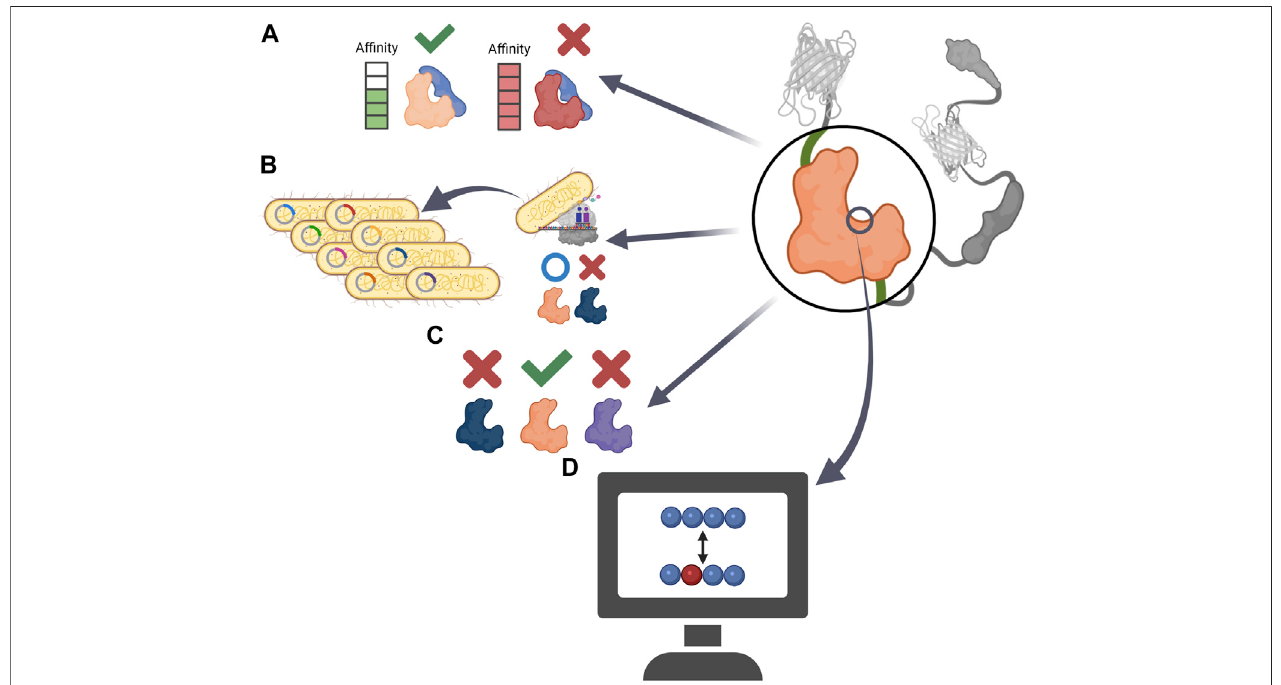
FIGURE3| Schematicprecedentsofliganddomainoptimization (A) ConstructingaGEBthatcanreversiblyrespondtoexternalstimulibyusingliganddomainwith adequate af fi nity to sensor domain. (B) By replacing the ligand domain that Escherichia coli could not express, the GEB could be applied to a high-throughput bacterial colony screen (C) Developing target speci fi c GEB by comparing the performance of ligand domains derived from various proteins. (D) Creating new ligand domain having low af fi nity to endogenous player via computational analysis.